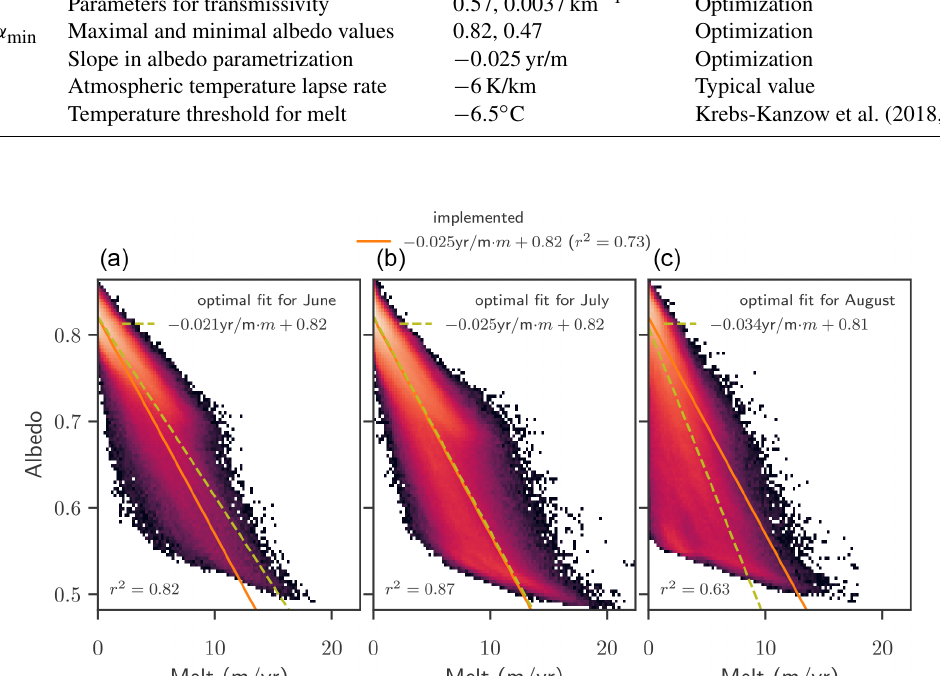
Figure A1. Fit for albedo parametrization. Histograms of albedo vs. melt in June (a) , July (b) , and August (c) over the period 1958–2019 in the MAR v3.11 dataset. Colours represent how often the combination of values is found in each grid cell on the ice sheet over the years. Note that the colour scale is logarithmic. Orange lines show the parametrization with parameters as used in PISM. Light green lines show the best linear fit for each month, with the parameters given in the